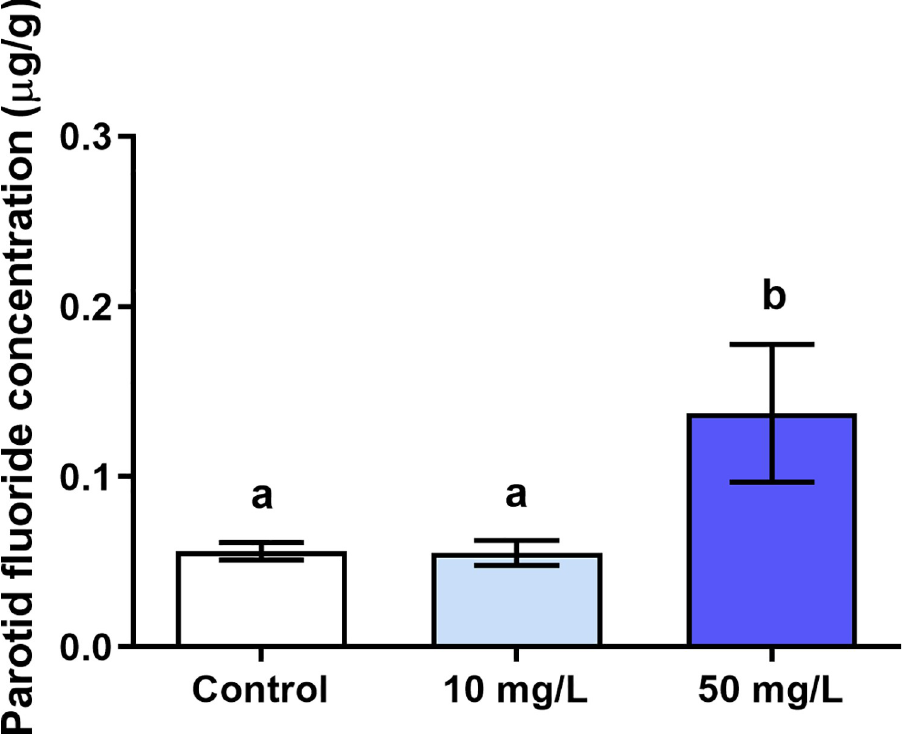
Fig 2. Fluoride concentration in the parotid glands. Analysis of fluoride (F) concentration in the parotid glands of mice (n = 30) in μ g/g, after 60 days of exposure to 0 mg/L, 10 mg/L and 50 mg/L of F (wet weight). Results are expressed as mean ± standard deviations. The different letters on the columns indicate significant differences among the groups according to One-way ANOVA test, with Tukey posttest, p < 0.05.